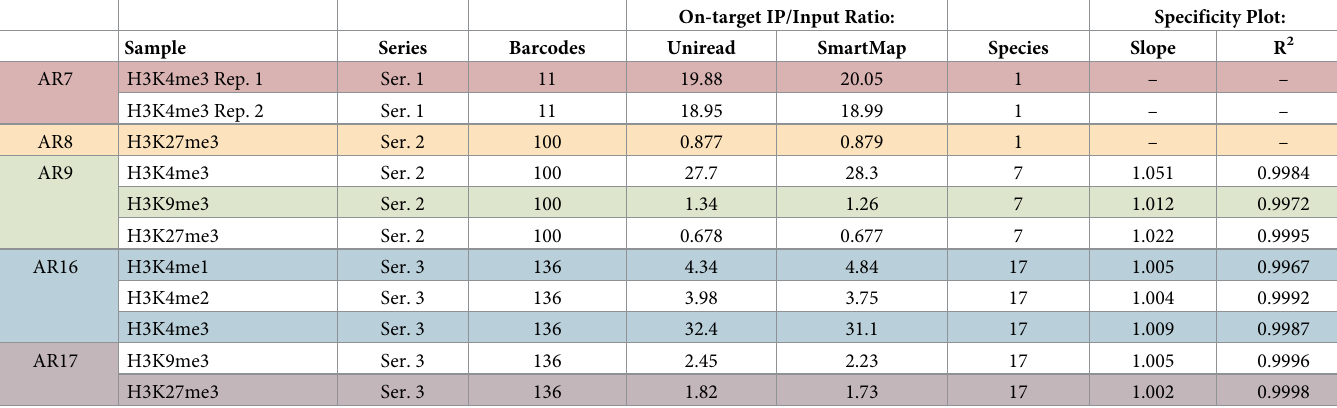
Table 4. Analysis of ICeChIP Calibrant Barcodes.